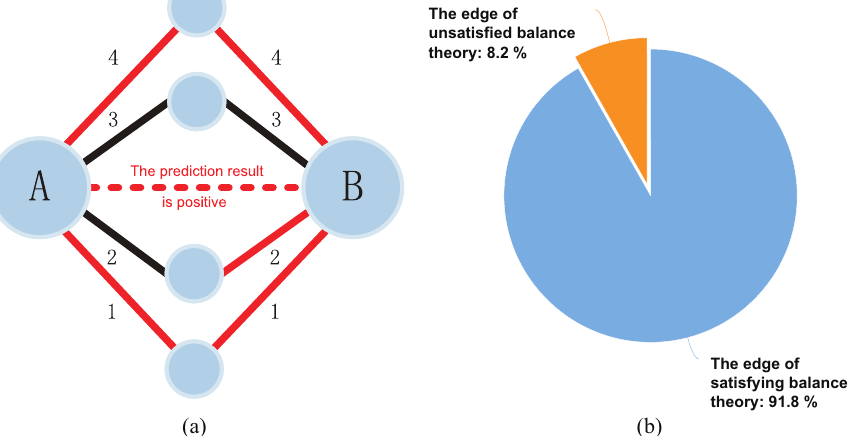
Figure 11. ( a ) An example of PPI satisfying balance theory in signed networks. According to the balance theory, it can be inferred that the connection between protein A and protein B is positive, negative, positive, and positive through routes 1, 2, 3, and 4, respectively. Since the theoretically positive quantity is more than the theoretically negative quantity, if the connection edge between protein A and protein B is predicted to be positive, it means that the predicted protein interaction satisfies the balance theory in the entire signed network. ( b ) The analysis result of the interaction network obtained after the prediction. It shows the proportion of edges satisfying balance theory and unsatisfied balance theory in the entire signed